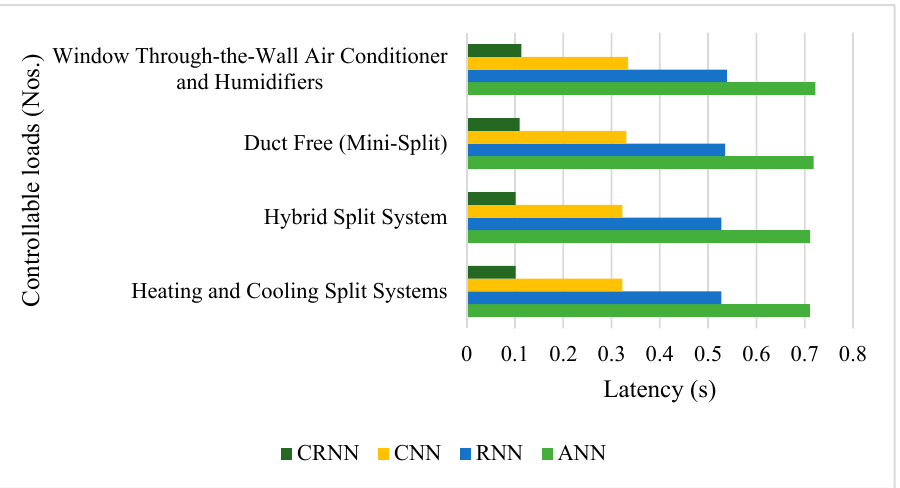
Figure 12. Latency (s) over various deep learning algorithms with controllable loads.